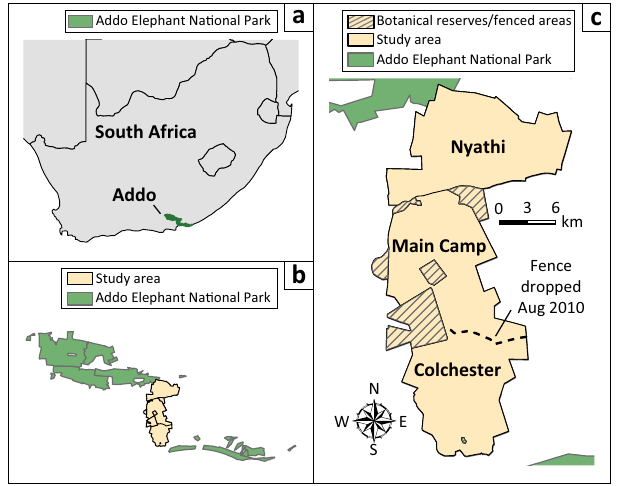
FIGURE 1: (a) Addo Elephant National Park exists in an aseasonal climatic system on the South African coast. (b) The elephant-accessible areas evaluated in this study lie at the heart of the larger Addo Elephant National Park. (c) Primary elephant-accessible areas of Addo Elephant National Park. The fence separating Main Camp and Colchester was dropped in August 2010, making both sections available to elephants. The Nyathi section remained isolated by fences from Main Camp for the duration of the study. Botanical reserves and other fenced areas are inaccessible to elephants. A smaller population of elephants occupies the Kuzuko section of Addo Elephant National Park (not pictured) and is not included in this